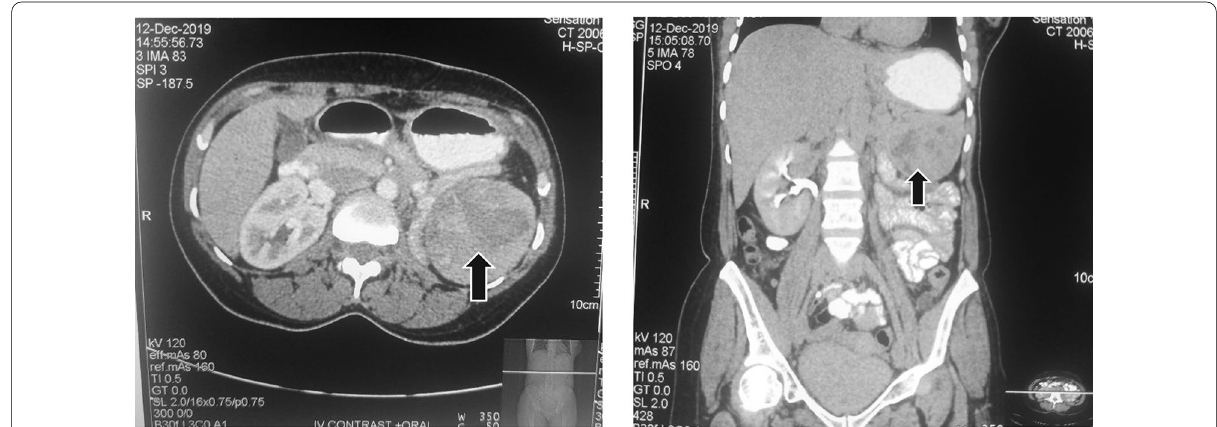
Fig. 2 a Axial CT of the abdomen showing contrast enhancing left hypochondrial mass and b . coronal section of the same abdomen (solid